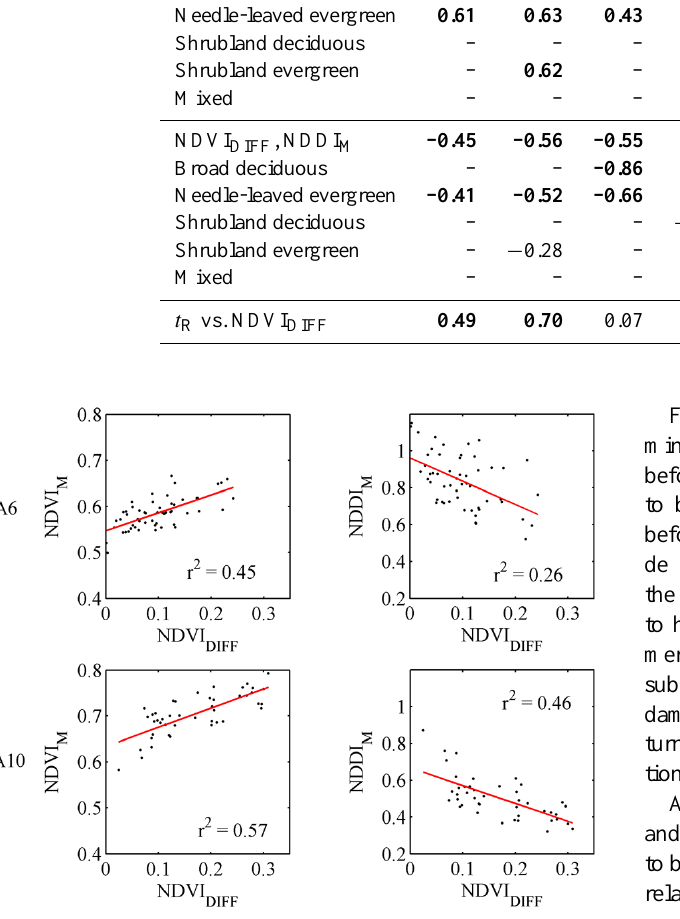
Fig. 11. Dispersion diagrams of the pairs { NDVI DIFF , NDVI M } (left panel) and { NDVI DIFF , NDDI M } (right panel) for pixels cor- responding to forests and shrubland for A6 (top panel) and A10 (bottom